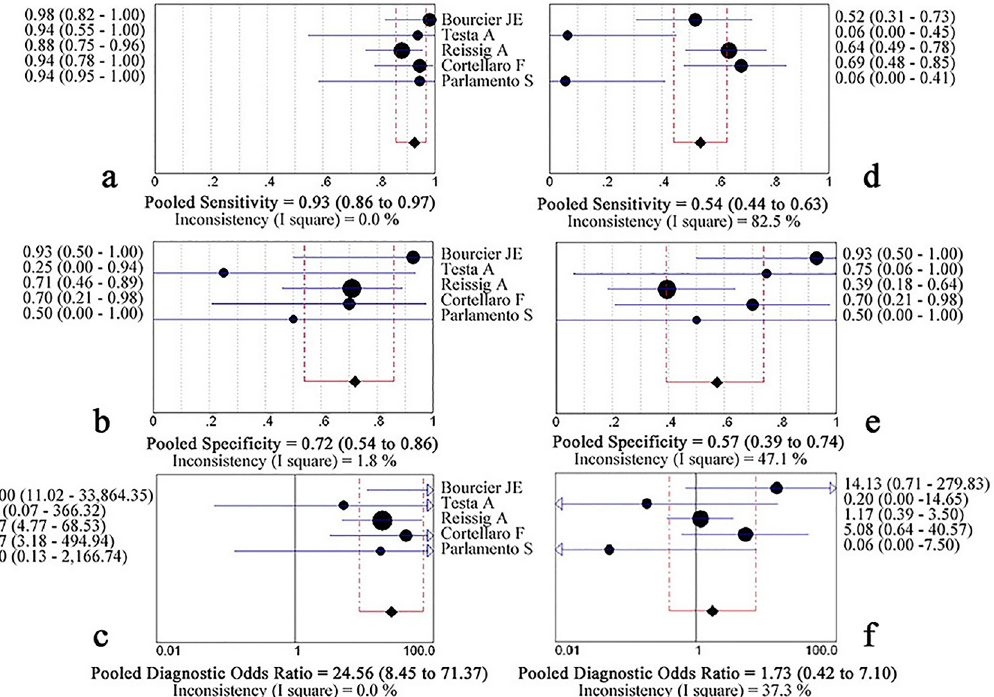
Fig 3. Forest plot for pooled sensitivity, specificity and diagnostic odds ratio of lung ultrasonography (a, b, c) and chest radiography (d, e, f) for the detection of pneumonia compared with chest computed tomography diagnosis.